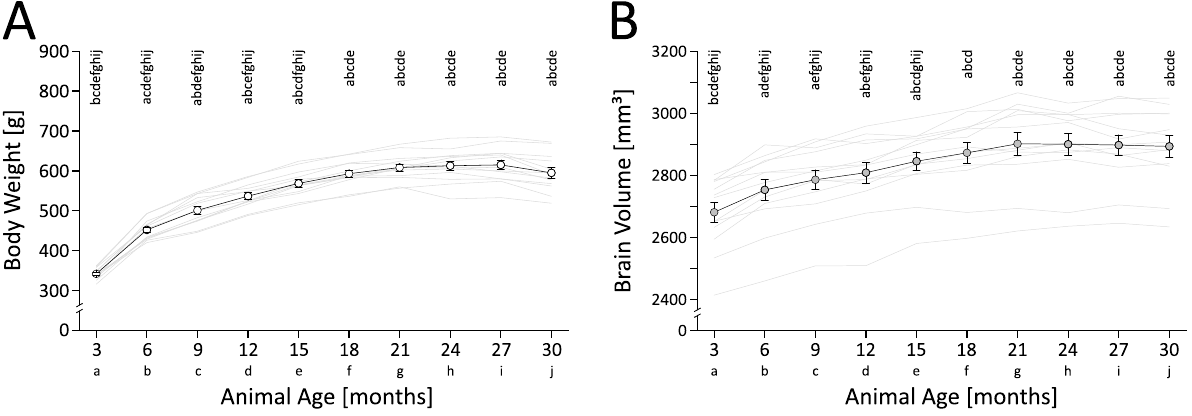
Figure 1. Bodyweight and total intracranial brain volume in male RccHan:WIST rats across life- time. ( A ) Bodyweight increased successively until 18 months of age; the maximum was reached at 27 months of age. ( B ) Total intracranial brain volume increased between 3 and 6, and between 12 and 15 months of age; the maximum was reached at 21 months of age. Individual measures and the mean ± SEM are shown. A total of n = 13 rats were included in the study. The measurements, the estimated percentage changes and the statistics of one-way RM ANOVA with Tukey HSD are shown in Supplementary Table S1A. The results of the post hoc test are shown as age-coded letters, representing a significance level of p <